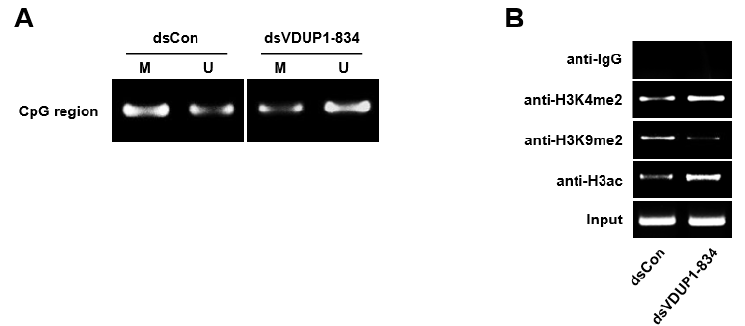
Figure 3. dsVDUP1-834 transfection induces DNA demethylation and histone modification. A549 cells were transfected with dsCon or dsVDUP1-834 (10 nM). ( A ) After modification with bisulfite, methylation-specific PCR was performed with primers specific to methylated (M) or unmethylated (U) CpG islands of VDUP1 promoter. ( B ) Chromatin immunoprecipitation (ChIP) assays were performed using control IgG or antibodies against H3K4me2, H3K9me2, or H3ac to pull down associated DNA. The precipitated DNA was amplified using primers specific to the dsVDUP1-834 target site, and input DNA was amplified as a loading control.